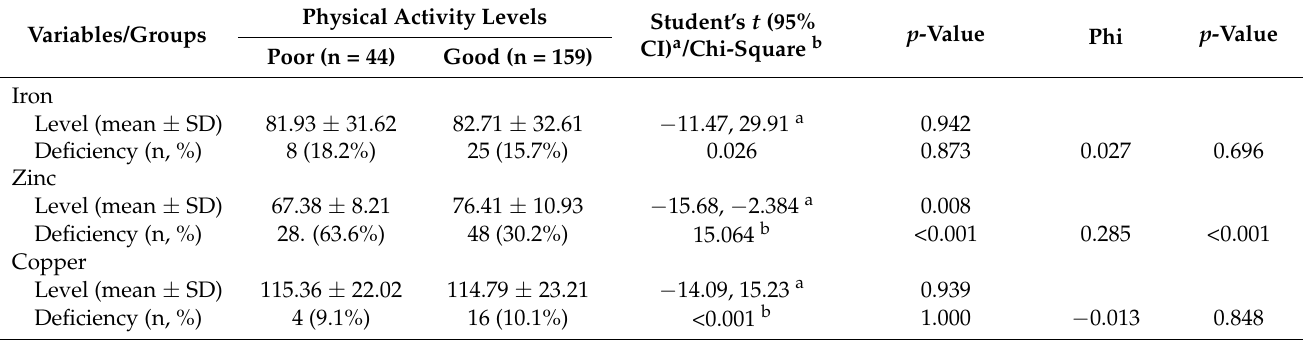
Table 5. Correlation of trace element levels and deficiency with physical activity levels.